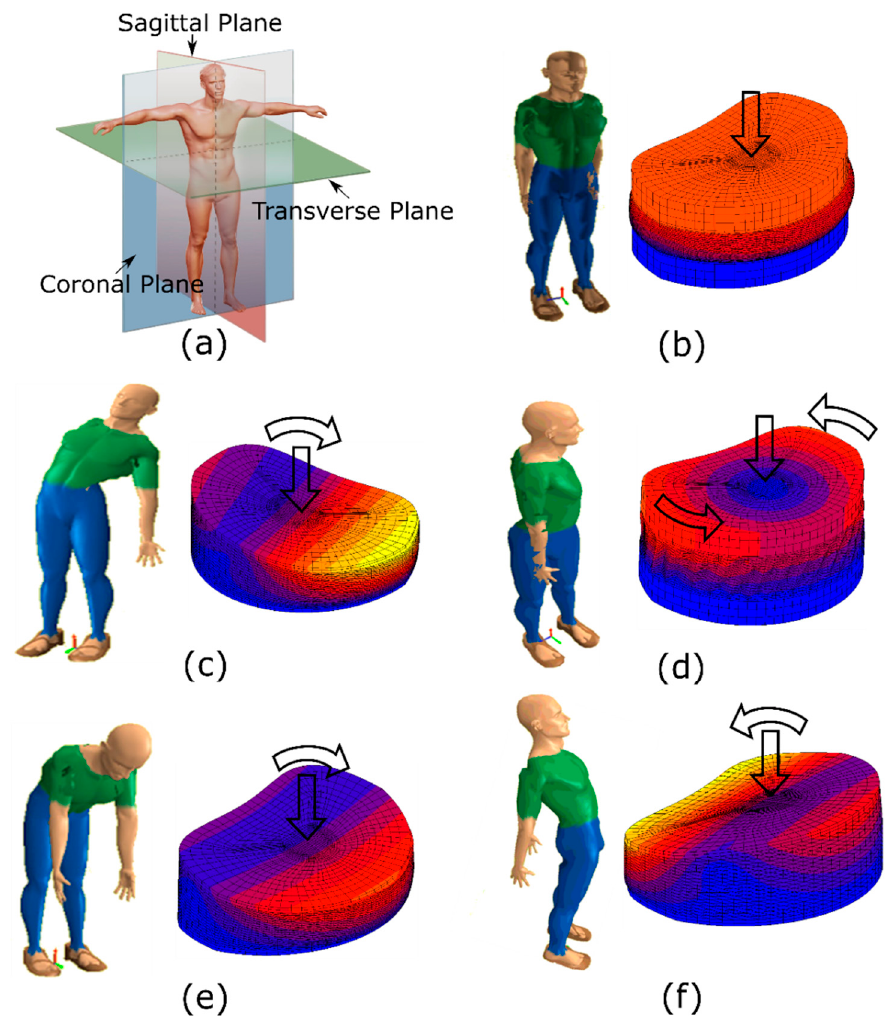
Figure 2. ( a ) Movement Planes; ( b ) Compression; ( c ) Lateral Bending; ( d ) Torsion; ( e ) Flexion; and ( f ) Extension.